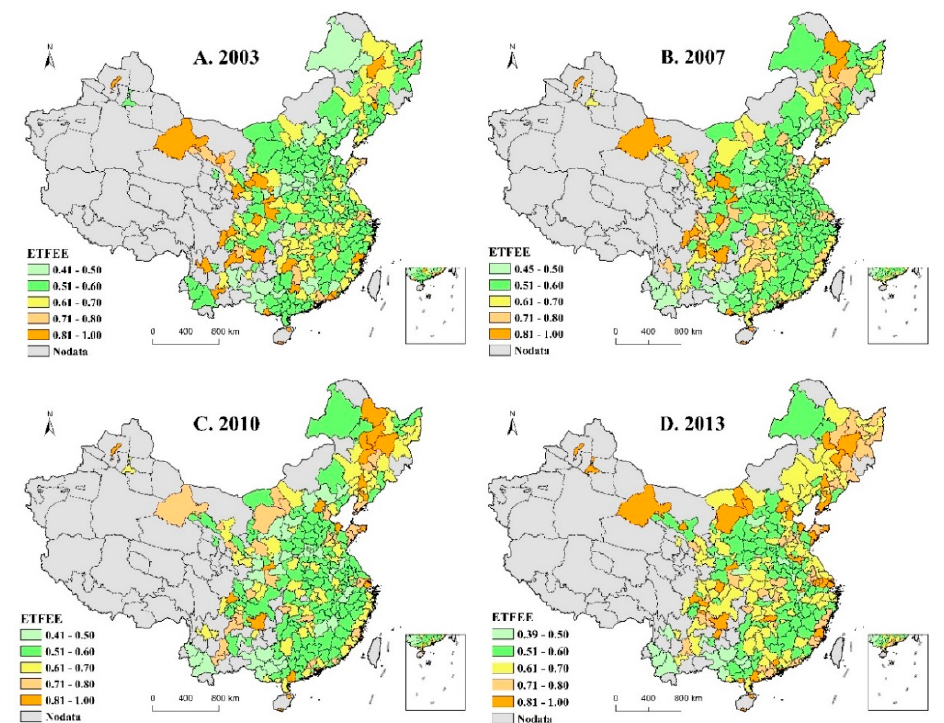
Figure 2. Changes in the spatial distribution pattern of ETFEE.